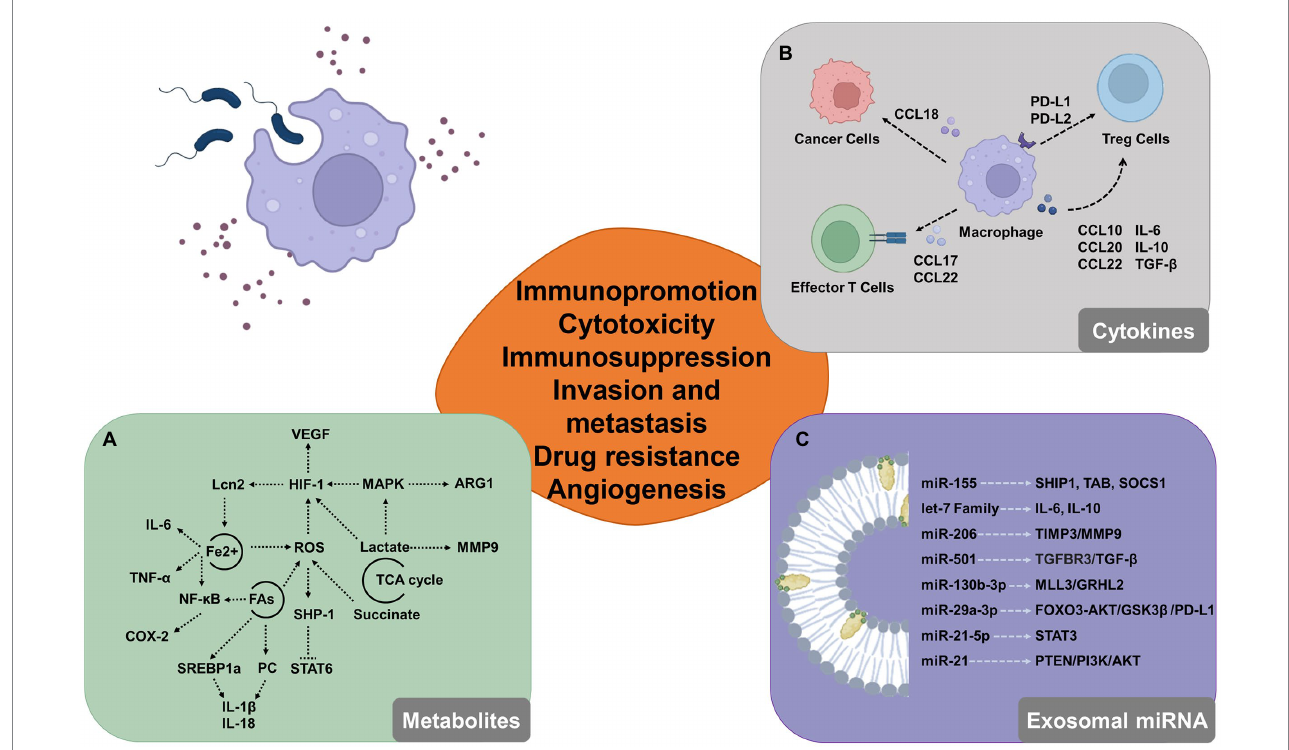
FIGURE 3 Potential involvement for macrophages that have been triggered by the microbiome in the tumor microenvironment. (A) By modifying the expression of intermediate metabolites, activated macrophages can modify glucose metabolism, iron cycling, and lipid metabolism and control the tumor microenvironment. (B) Activated macrophages release a variety of cytokines, chemokines, and growth factors that influence tumor formation by boosting cell proliferation and decreasing the activity of immune cells that can destroy tumors, like cytotoxic T cells. (C) Macrophage-derived exosomal miRNAs alter the immunological milieu by targeting proteins and activating